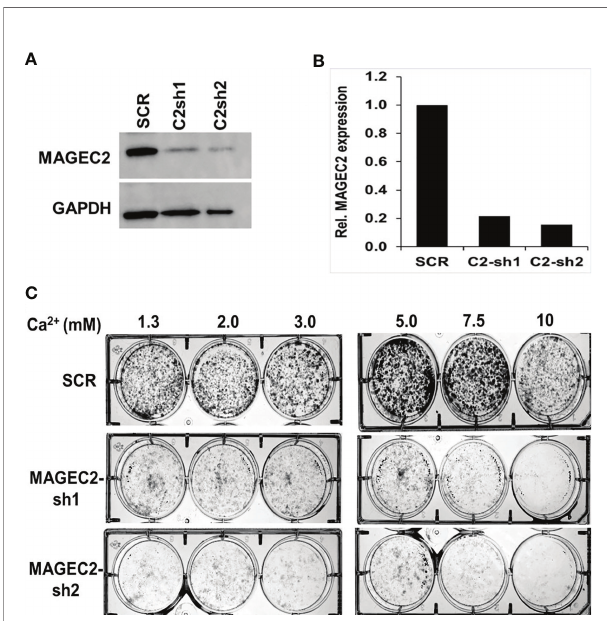
FIGURE 5 | Effect of MAGEC2 down regulation on the growth of TNBC cells in vitro . (A) BT-549 cells were transfected with control (SCR) or shRNA plasmids (MAGEC2-sh1 and MAGEC2-sh2) targeting MAGEC2. The expression of MAGEC2 was con fi rmed by western blotting. (B) The protein bands were quanti fi ed using the NIH ImageJ software. (C) Control and MAGEC2 down regulated cells were cultured in complete medium supplemented with the indicated concentrations of Ca 2+ and cultured for up to 10 days. Cells were fi xed and stained with crystal violet and the images were digitally